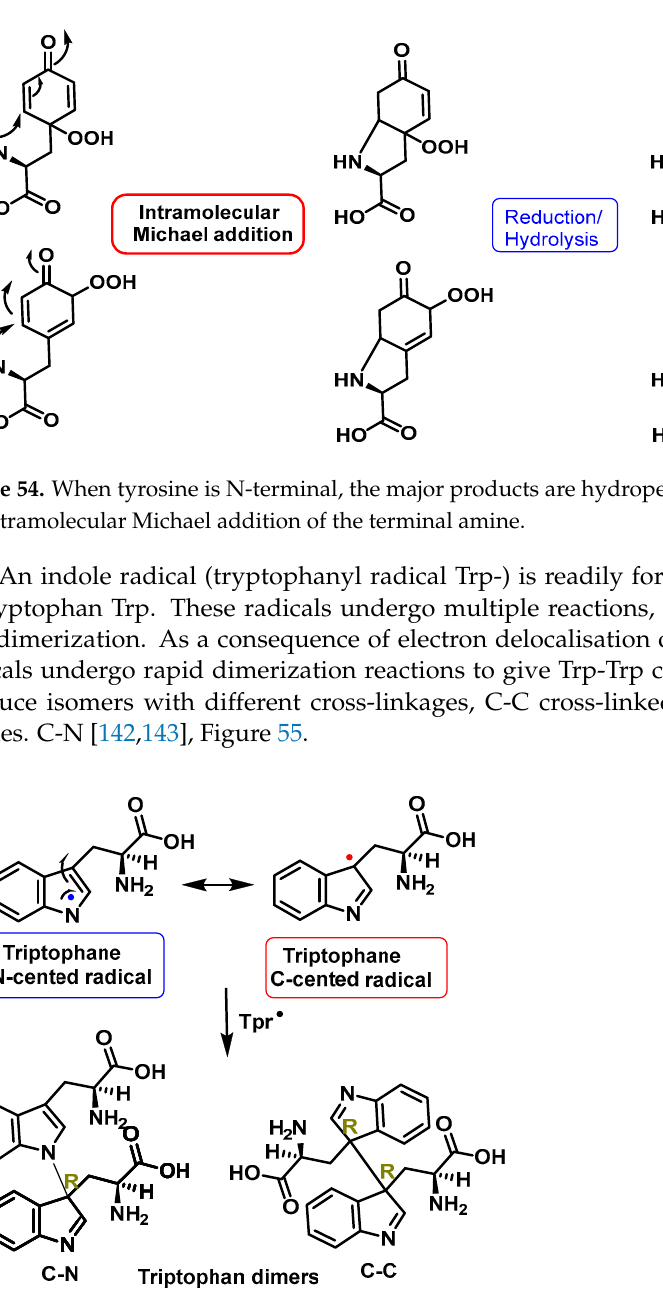
25 of 45 Figure 53. Formation and reactions of Tyr phenoxyl radicals Tyr • . Tyr • self-react to produce di-Tyr (o,o ′ -di-Tyr, blue; iso-di-Tyr, black). Reactions of superoxide with tyrosyl radicals on the original amino acid or on small peptides are fast enough to compete with both superoxide dismutation and tyrosyl radical combination to form dityrosine derivatives. The production of di-Tyr crosslinks is limited by these alternative reactions, such as the short-lived peroxide formation reaction. For tyrosyl radicals, the reaction with superoxide to form the addition product (tyrosine hydroperoxide) is three times faster than dimerization [139,141]. Tyrosine and aminophenols are anomalous in that they undergo many more additions, the amino group attaches to the b-position of the unsaturated a,b.ketone to give a heterocyclic product. When tyrosine is N-terminal, the main products are hydroperoxides that have been cyclised via 1,4-conjugated addition (intramolecular